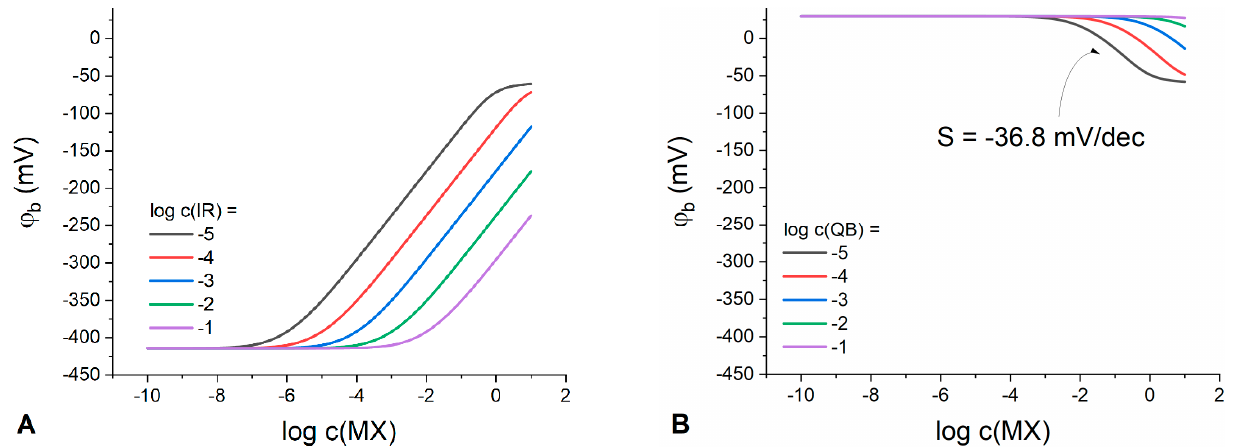
Figure 2. Calculated dependencies of the phase boundary potential on MX concentration in the solution at varied IR ( A ) or Q + B − ( B ) content in the polymeric membrane (indicated in the plot). k Q = 10 3 , k B = 10 2 ; k M = 10 − 6 , k X = 10 − 4 ; k I = 10 − 5 , k R = 10 9